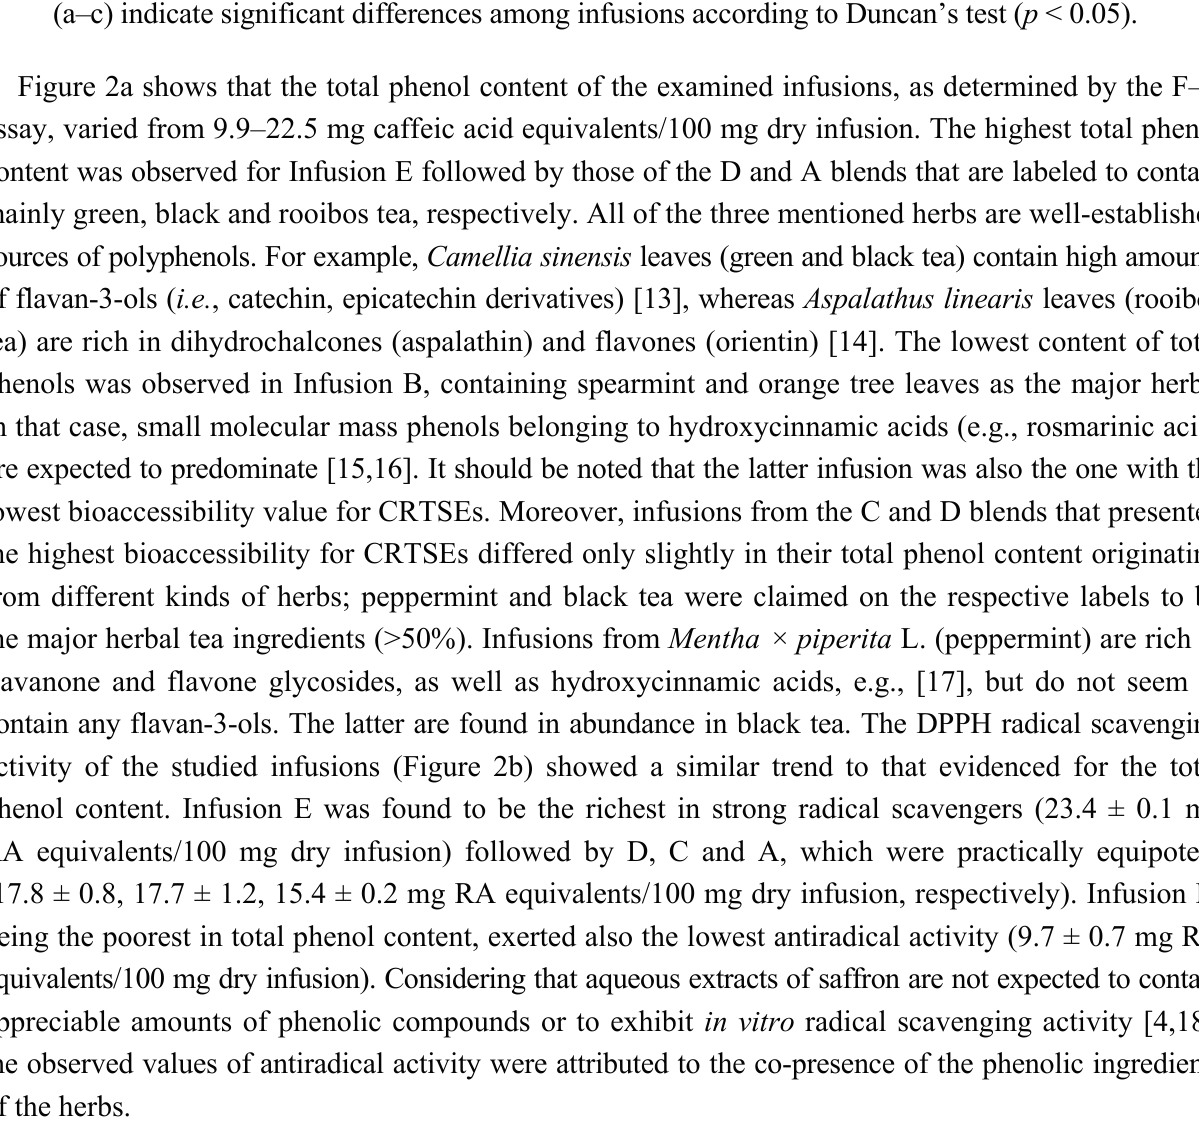
Figure 2. ( a ) Total phenol content (expressed as caffeic acid equivalents, CA) and ( b ) DPPH radical scavenging activity (expressed as rosmarinic acid equivalents, RA) of Infusions A–E. Data are the means of three independent measurements ± SD; different lowercase letters (a–c) indicate significant differences among infusions according to Duncan’s test ( p <